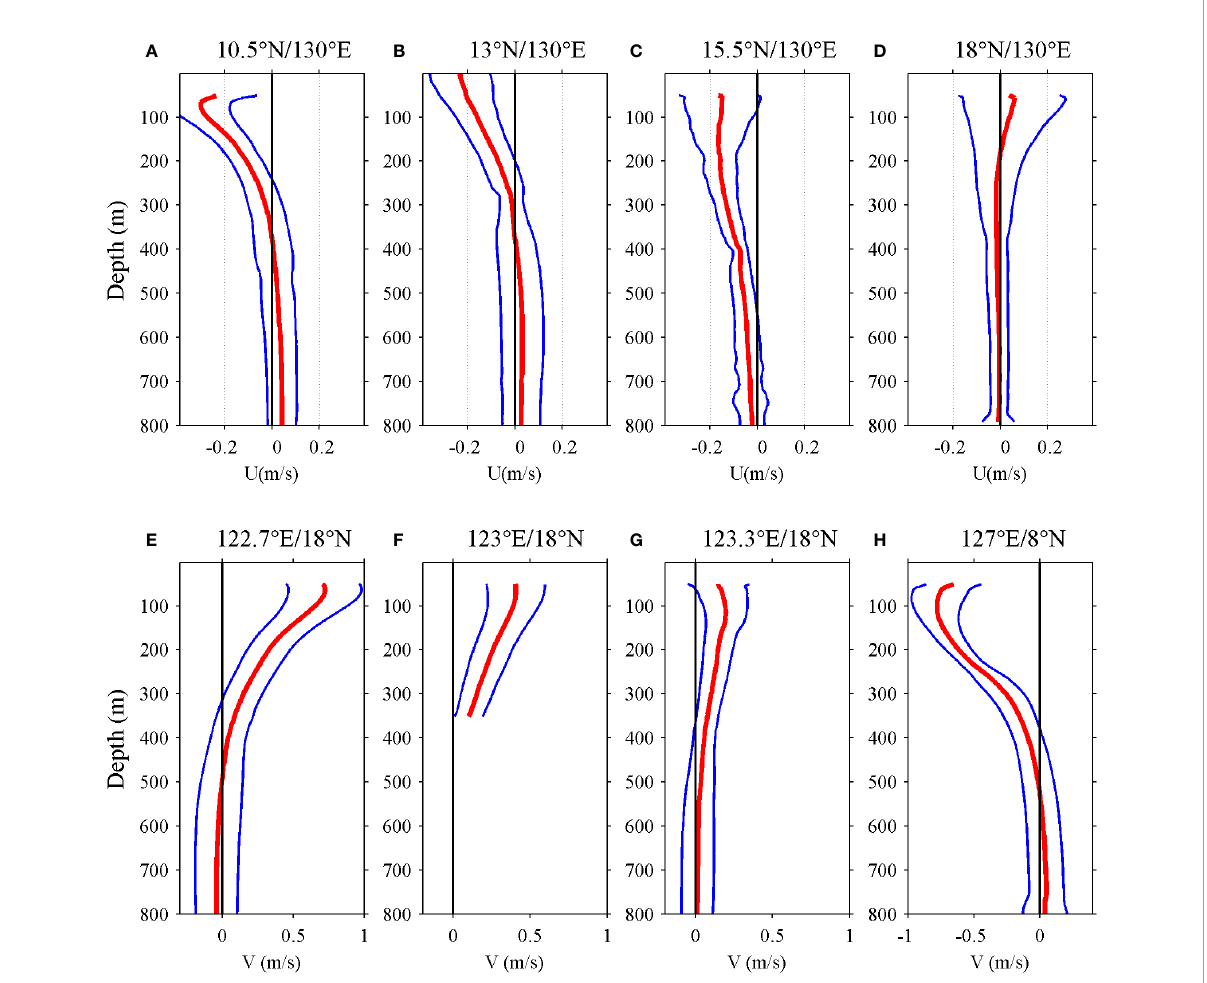
FIGURE 2 Mean velocities (red lines) and associated standard deviations (blue lines) at (A) 10.5°N, (B) 13°N, (C) 15.5°N, and (D) 18°N along 130°E; (E) 122.7° N, (F) 123°N, (G) 123.3°N along 18°N; and (H) 127°E/18°N. The black line indicates zero velocity. (Units are